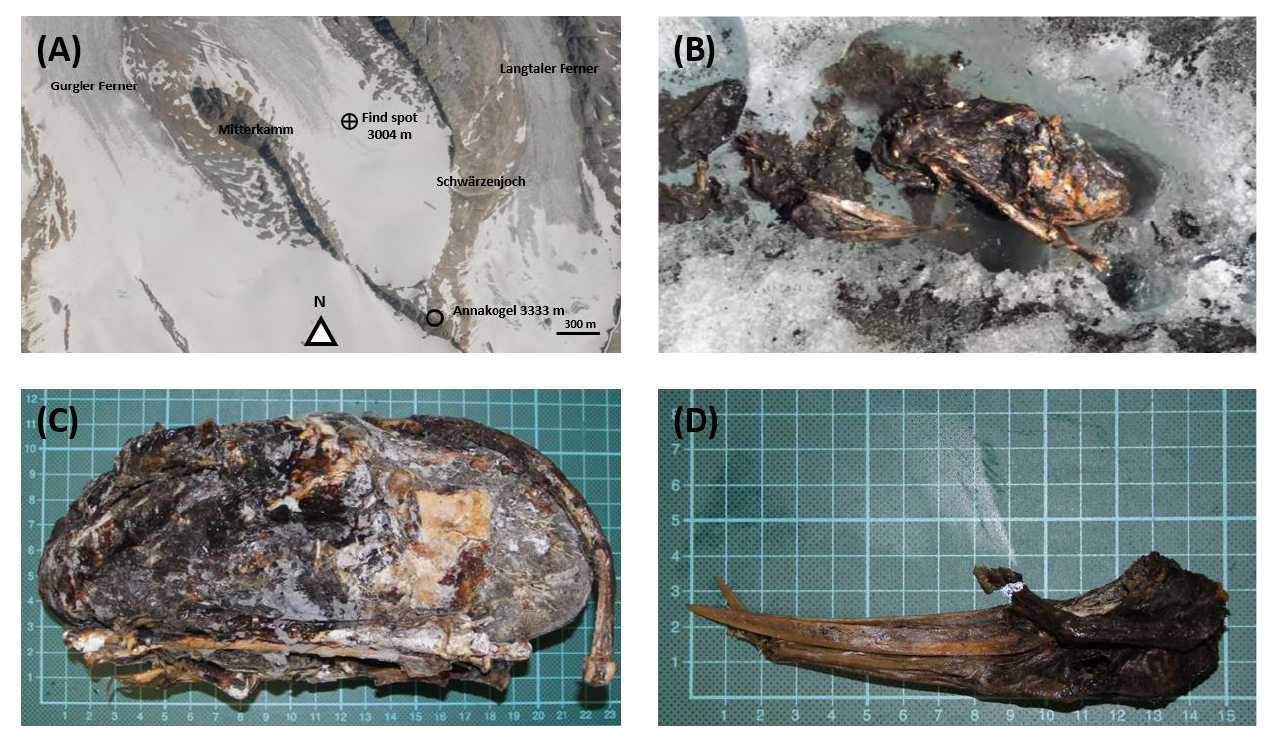
Figure 1. ( A ) Location of sample collection of the glacier mummy on the Gurgler Ferner using tirisMaps (https://maps.tirol.gv.at, accessed on 22 November 2022). This location is west of the sample collection of Ö tzi, about 11.16 km apart. ( B ) Presentation of the glacier mummy at first finding with ( C ) focus on the corpus and the ( D ) detailed skull.